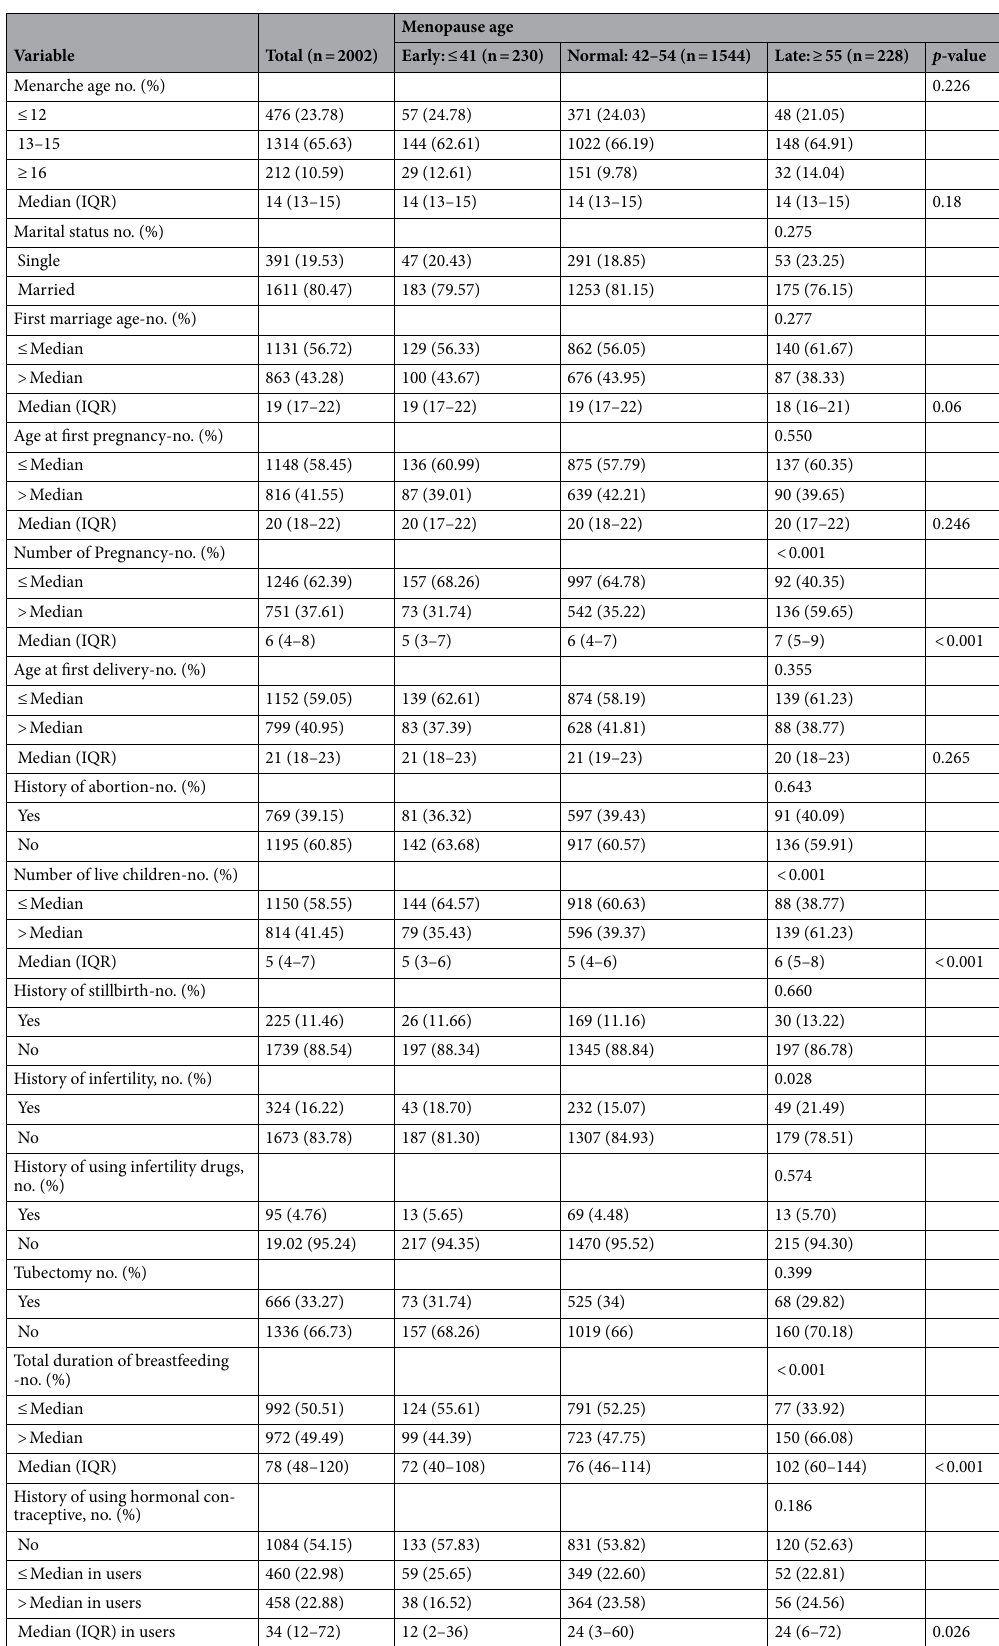
Table 2. Reproductive characteristics of women according to age at menopause in Rafsanjan Cohort Study